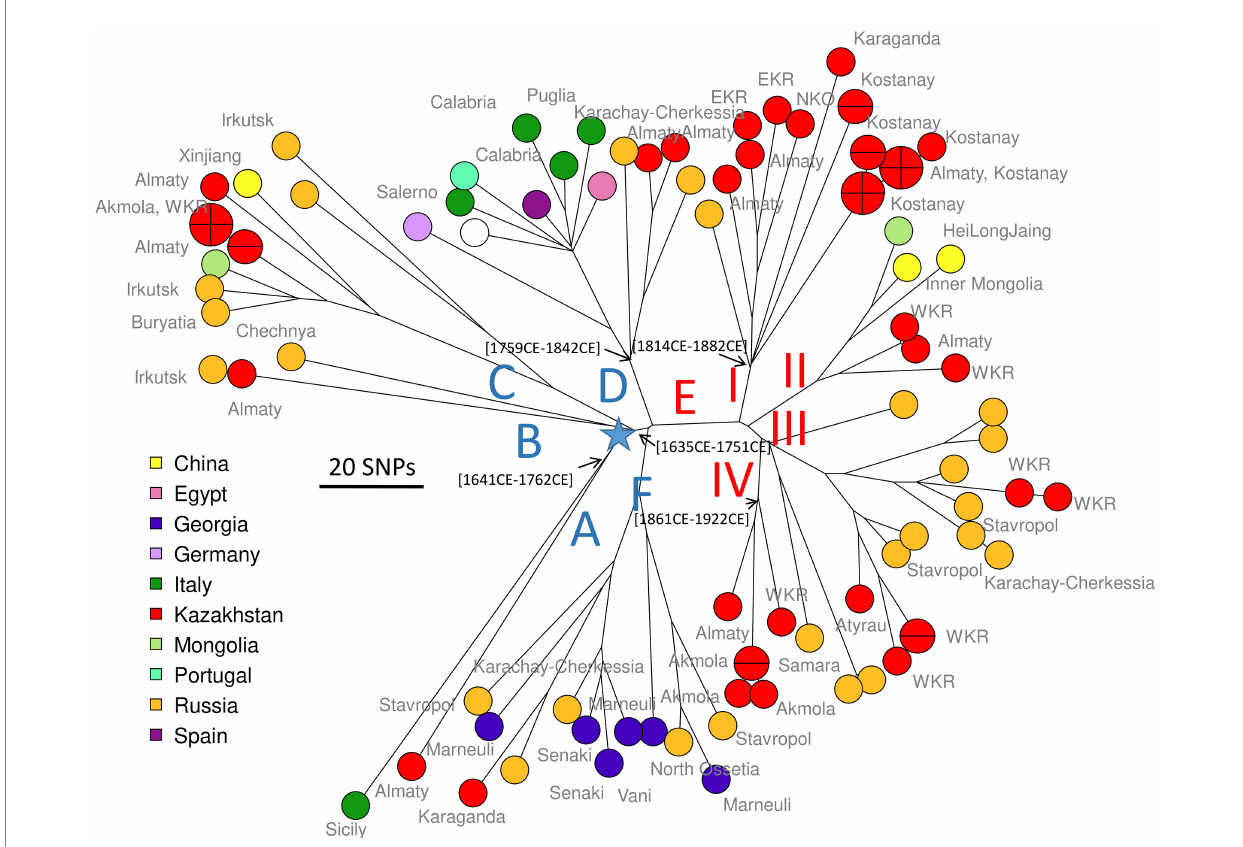
FIGURE 4 Zoom on B. abortus subclade C1, position of the Kazakhstan strains within the global subclade C1 phylogeny. Close-up on Figure 3. Strains are colored according to country of origin as indicated and labeled with region of origin when known. The blue star indicates the root of the phylogeny (branching point toward B. abortus clade B strain Tulya used as outgroup). Branch names A to F defined in Figure 1 are shown. Representative estimated divergence dates are indicated (CE, common